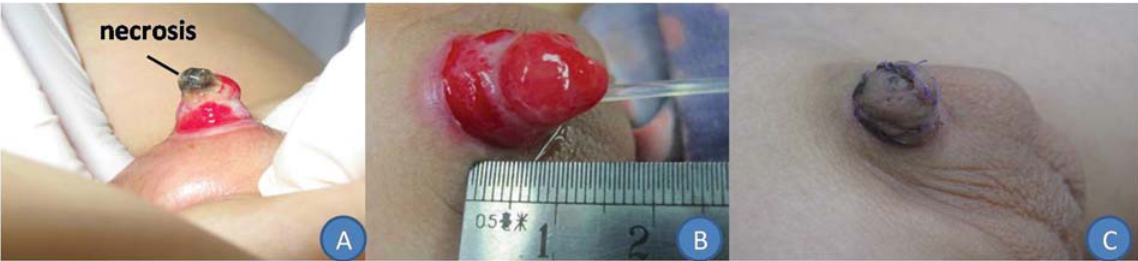
Fig. 3 A 6.6-year-old boy suffered an electric cautery ritual circumcision-related penile injury and presented with loss of the penile skin and the glans penis ( A ). After debridement ( B ), the split-thickness skin graft survived completely as observed 1 month after surgery ( C ).